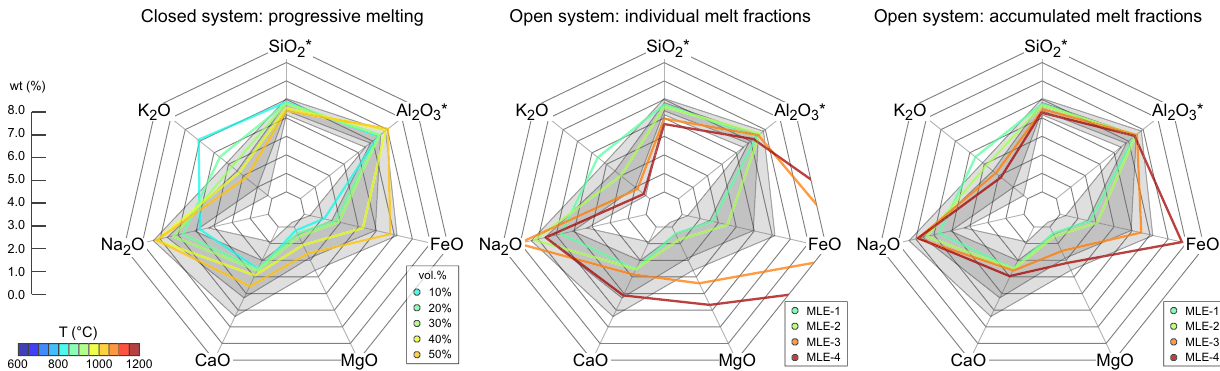
Figure 2. Major-element compositions for melts produced along a thermal gradient of 75 °C/kbar. Colors represent the temperature range at which each melt fraction equilibrated and separated from the source. Dark and light gray regions represent the mean composition of natural Archean TTGs within ± 1σ and ± 2σ 1 ,